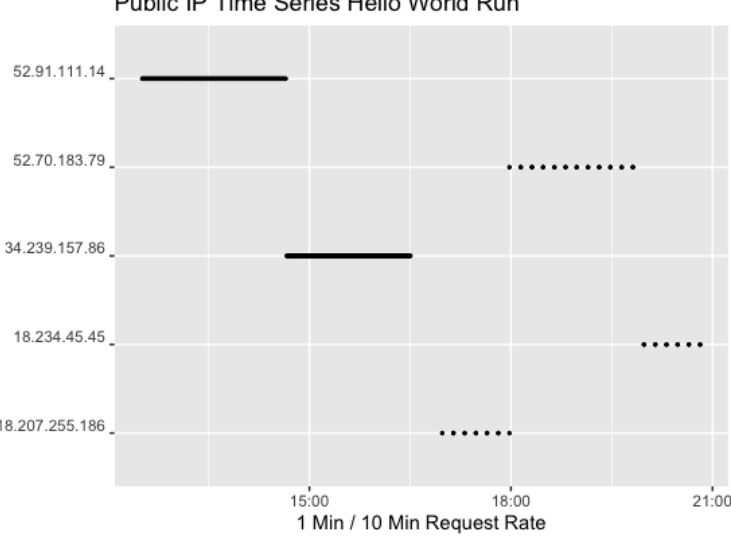
Figure 17. IP changes of a 1 min and 10 min request rate interval (Hello World